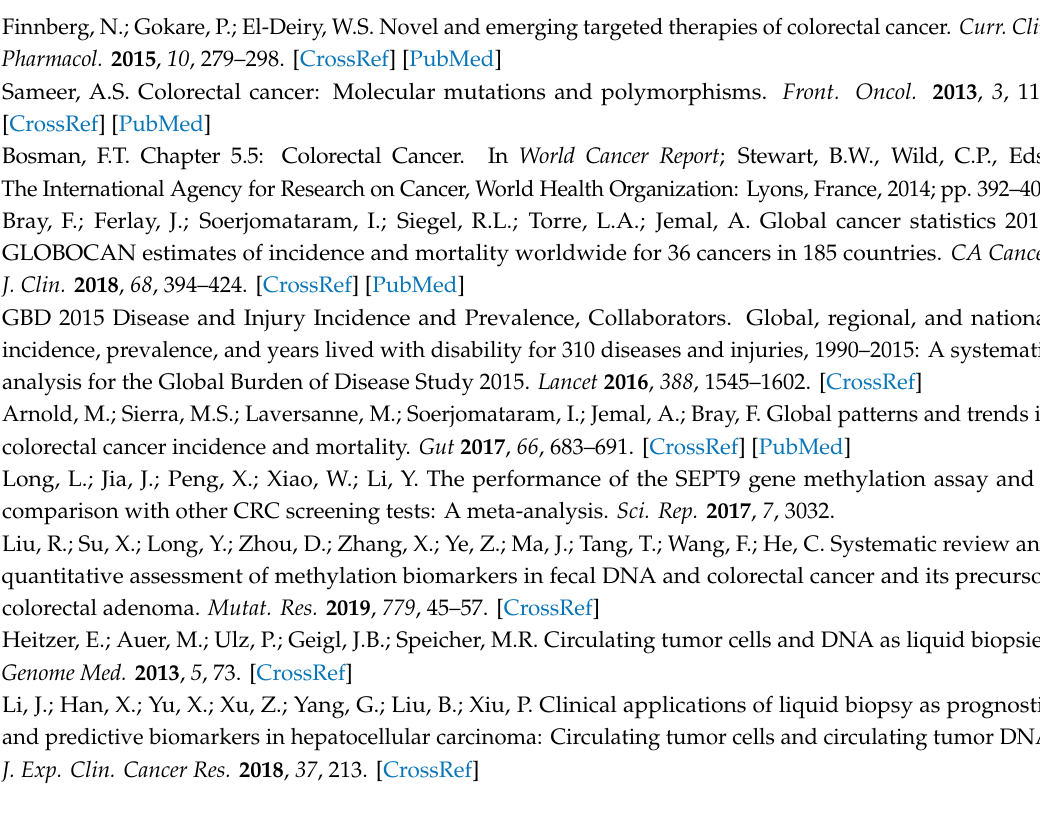
Table S1: Key examples of up-regulated miRNAs extracted from the 9-miR signature and compared with up-regulation of miR.141-3p, miR-221-3p and miR-222-3p, Table S2: Clinical data of recruited CRC patients, Table S3: Examples of molecular targets of the miRNA-signature, Table S4: NGS analysis data, Table S5: List of employed miRNA